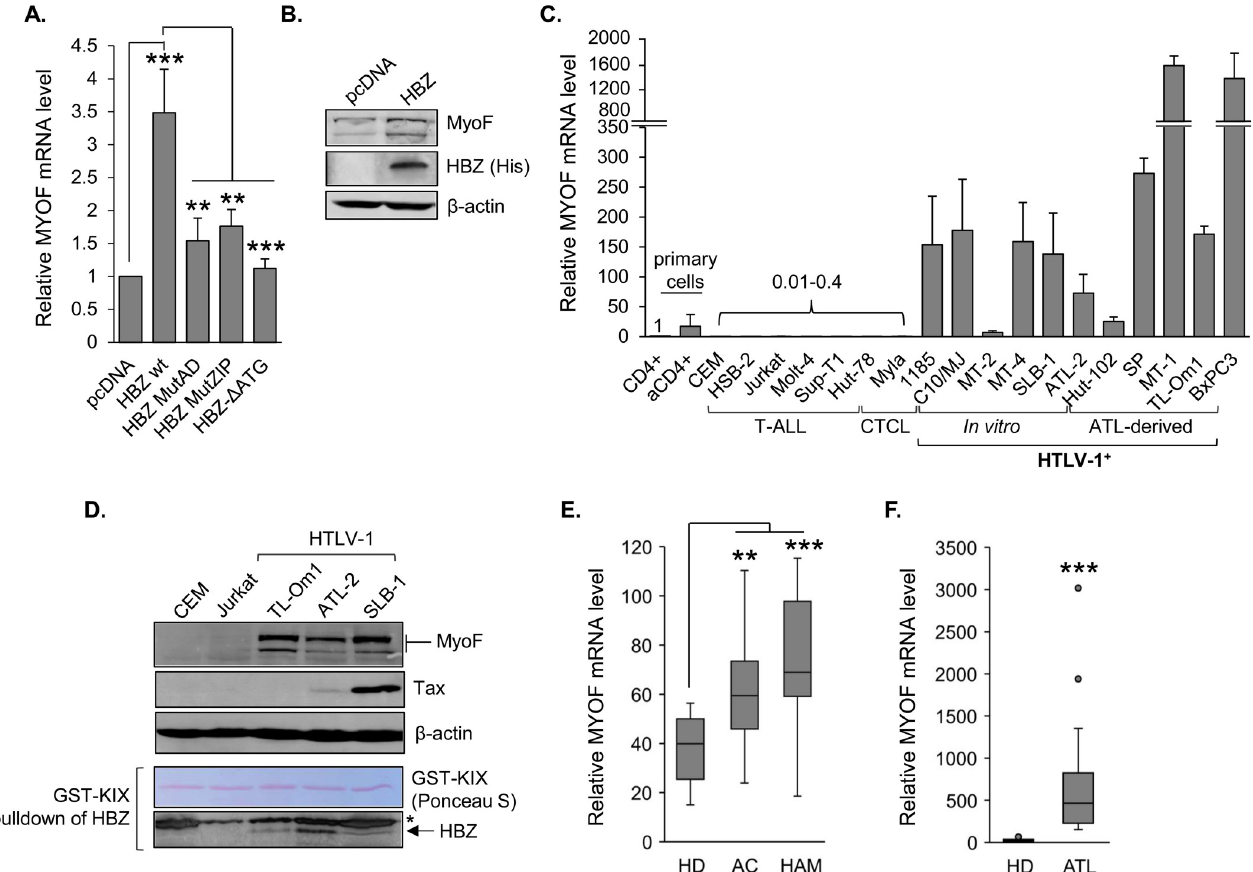
Fig 1. MyoF is expressed in HBZ-expressing cells and in HTLV-1-infected T-cells. (A) Relative MYOF mRNA levels in the indicated HeLa cell lines. The graph shows qRT-PCR results averaged from four independent experiments with values normalized to that of the empty-vector clone, pcDNA (set to 1), for each replicate. Error bars show standard deviations; �� p < 0.01, ��� p < 0.001. (B) MyoF expression in empty vector (pcDNA) and HBZ-HeLa clones. Whole cell extracts (50 μ g) were analyzed by Western blot using antibodies against MyoF, HBZ (6xHis) and β -actin. (C) Relative MYOF mRNA levels in resting and activated primary CD4 + T-cells and in T-cell lines. The graph shows qRT-PCR results averaged from two independent experiments in which values were normalized to those for the resting CD4 + T-cells (set to 1), error bars show standard deviations. Numbers above the bars indicate expression levels relative to the resting CD4 + T-cells. HTLV-1-negative lines are T-cell acute lymphoblastic leukemia lines (CEM, HSB-2, Jurkat, Molt-4 and SupT1) and cutaneous T-cell leukemia lines (HUT-78 and Myla); in vitro transformed HTLV-1-positive cells are 1185, C10/MJ, MT-2, MT-4 and SLB-1; ATL-derived cell lines are ATL-2, HUT-102, SP, MT-1 and TL-Om1. aCD4+ is activated CD4 + T-cells. BXPC3 is a pancreatic cancer cell line. (D) MyoF expression in T-cell lines. Whole cell extracts (45 μ g) were analyzed by Western blot using antibodies against MyoF, Tax, β -actin and HBZ. Endogenous HBZ was enriched by affinity precipitation using GST-KIX (Ponceau S-stained). (E) Tukey boxplots (showing MYOF transcript levels partitioned by healthy donor (HD), asymptomatic carrier (AC), HTLV-1 associated myelopathy (HAM) and (F) adult T-cell leukemia (ATL) from published microarray data: GEO accession numbers GSE29312 [103] and GSE14317 [104] for (E) and (F), respectively; boxplot ends of each whisker are set to 1.5 times the interquartile range above the third quartile and below the first quartile; �� p < 0.01, ��� p < 0.001.